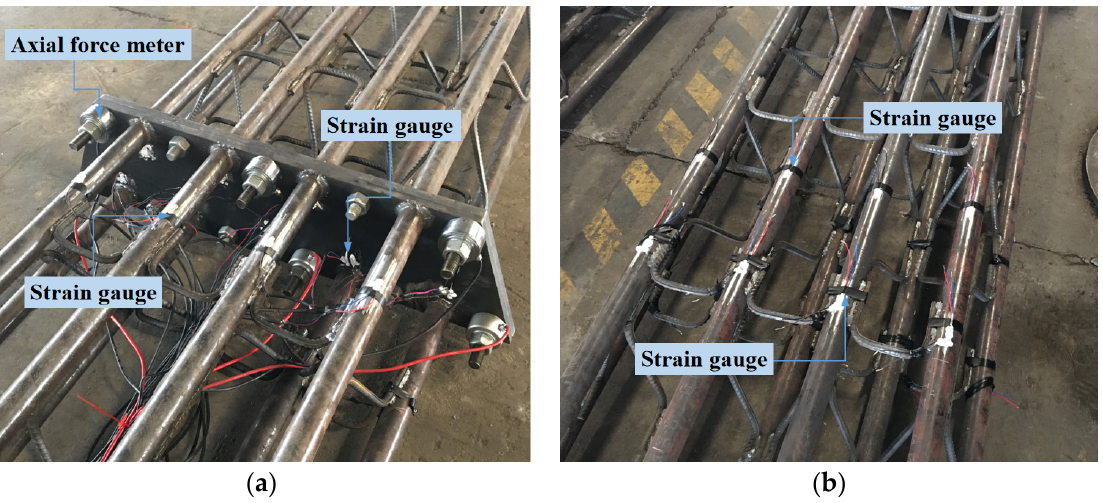
Figure 10. Layout of measuring points. ( a ) The end-plate joint component and ( b ) the jointless com- ponent.